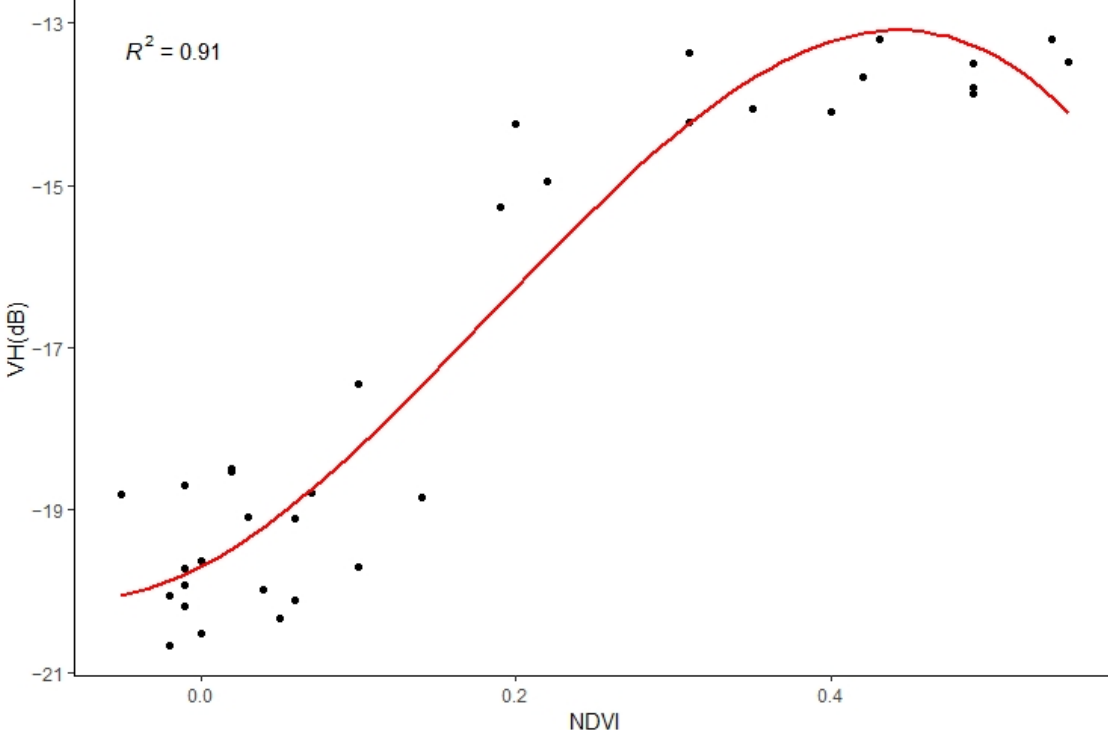
Figure 6. Correlation between NDVI and VH backscatter from multiple-incidence angles using the polynomial regression model on plot ID2.